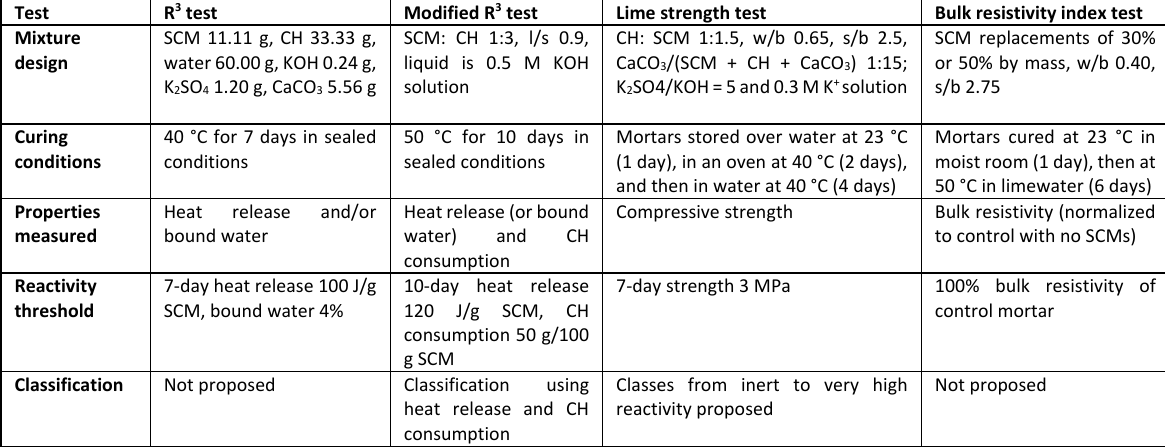
Table 1. Overview of mixture design, curing, properties measured, reactivity thresholds, and classification in different reactivity tests [8,9,14 ‐ 18]. The notations used are: l/s – liquid/solid, w/b – water/binder, and s/b – sand/binder, CH – calcium hydroxide. All ratios are by mass.